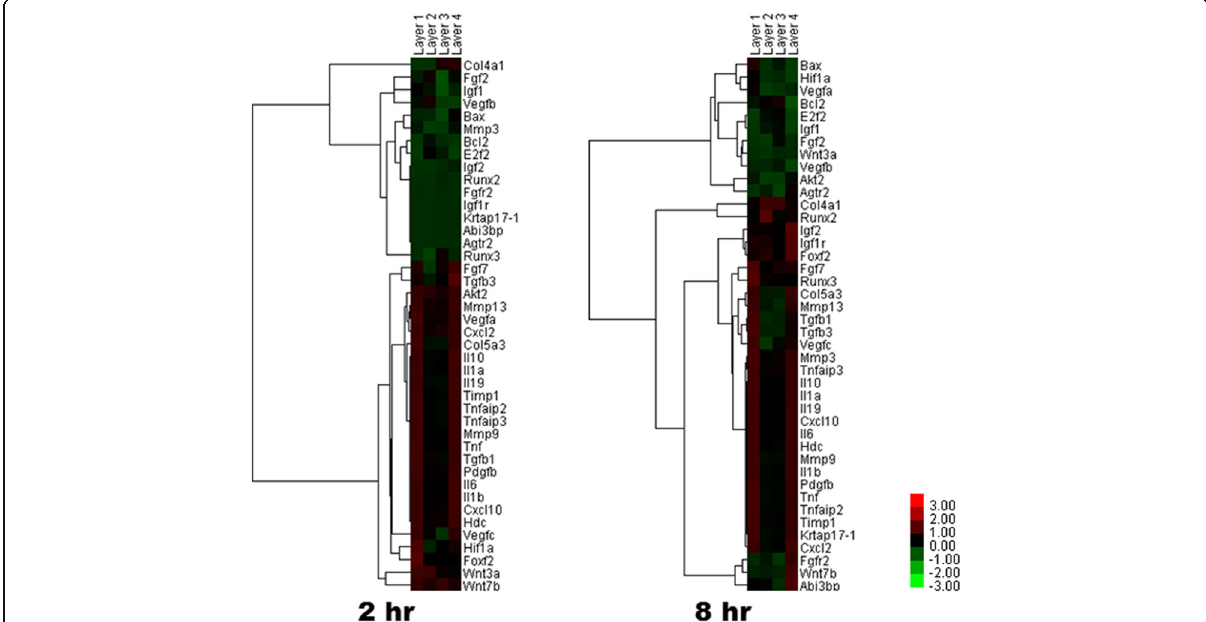
Fig. 2 A gene tree with cluster analysis. The genes associated with inflammation and angiogenesis were highly expressed in layer 1 and 4 groups at 2 h. The elevated expression of some genes persisted until 8